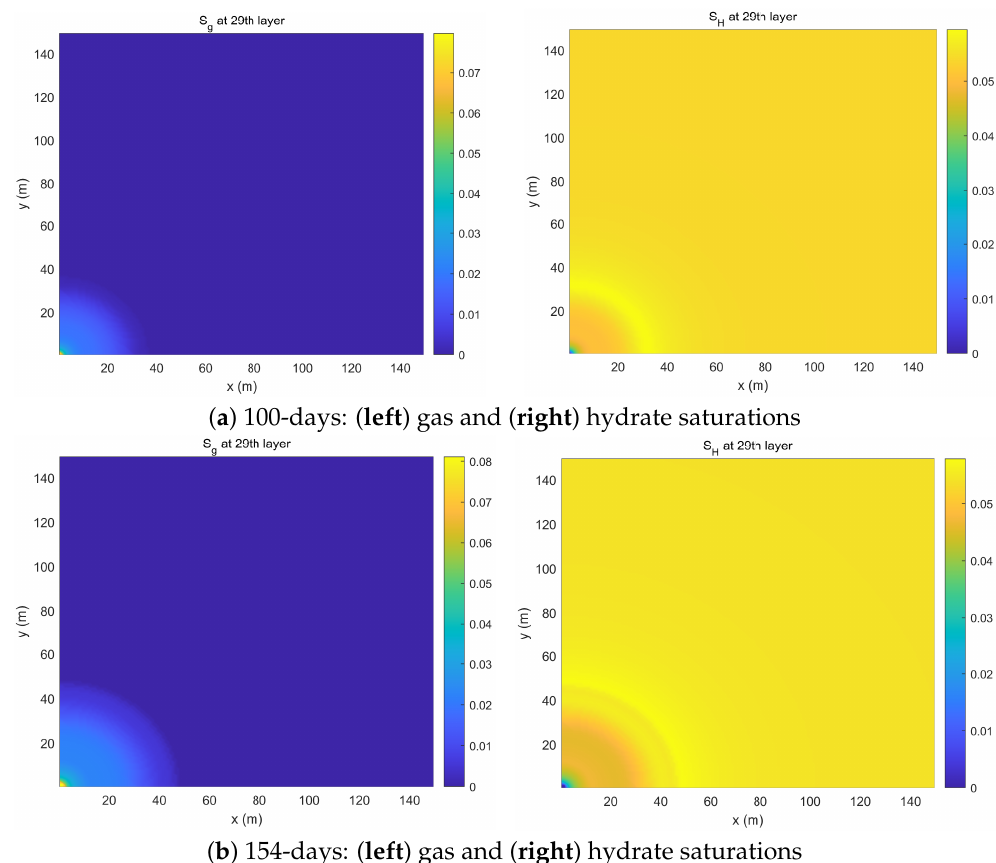
Figure 10. Gas and hydrate saturations in the converted 3D Cartesian domain at the 29th layer within the mud: ( a ) after 100 days and ( b ) after 154 days. The origin is where the wellbore is